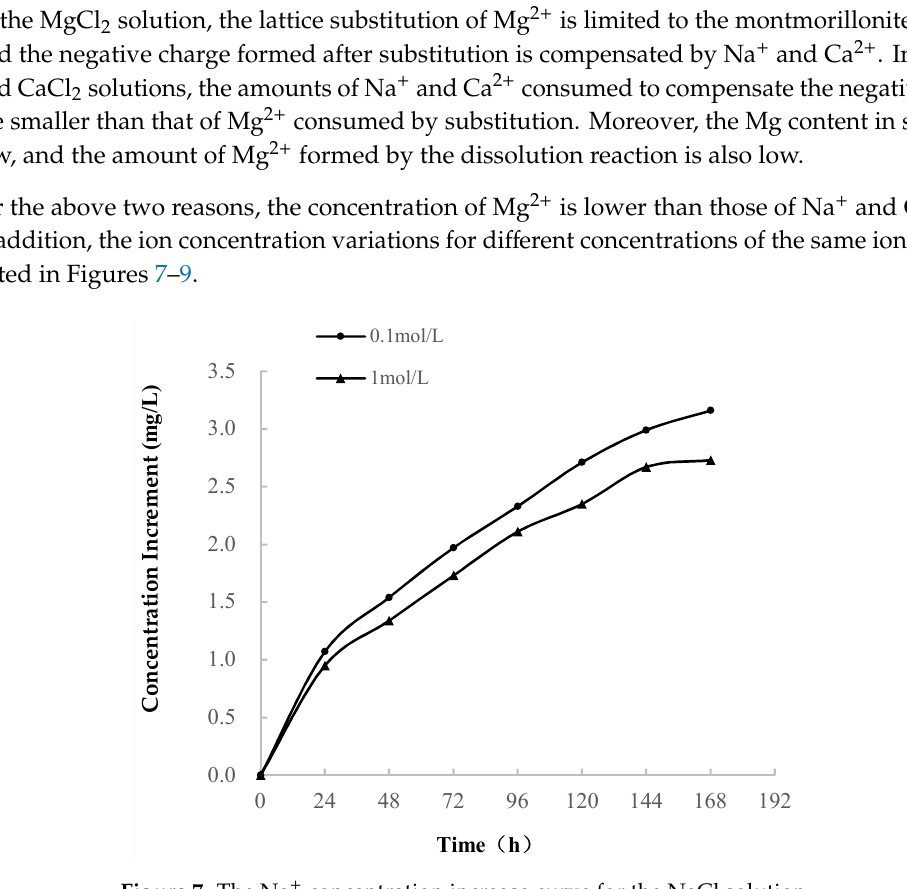
Figure 7. The Na + concentration increase curve for the NaCl solution.